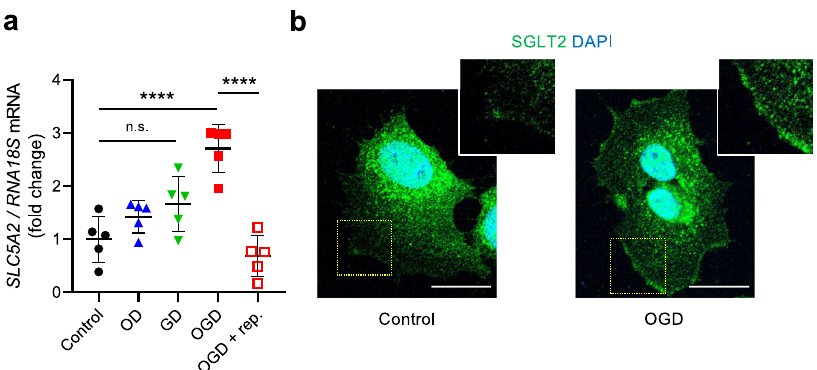
Fig. 4 SGLT2 expression in cultured pericytes is upregulated by glucose and/or oxygen deprivation. a Cultured brain pericytes were treated with GD for 16 h, OD for 16 h, OGD for 16 h, or OGD followed by 24-h reperfusion (rep.) with normal glucose and oxygen level. The mRNA expression level of SLC5A2 was quanti fi ed using qPCR and normalized to that of RNA18S ( n = 5). b Representative images of immuno fl uorescence for SGLT2 (green) and DAPI (blue) in pericytes treated with or without OGD for 16 h (scale bar = 20 μ m). Data are presented as dot-plots of individual experiments and mean values ±